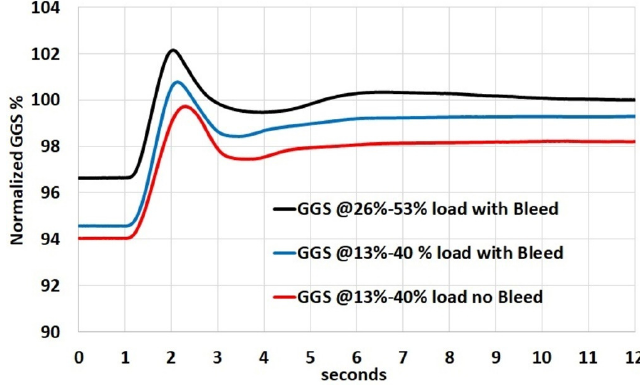
Figure 8. Normalized gas generator speed (GGS) considered as input in the engine model.